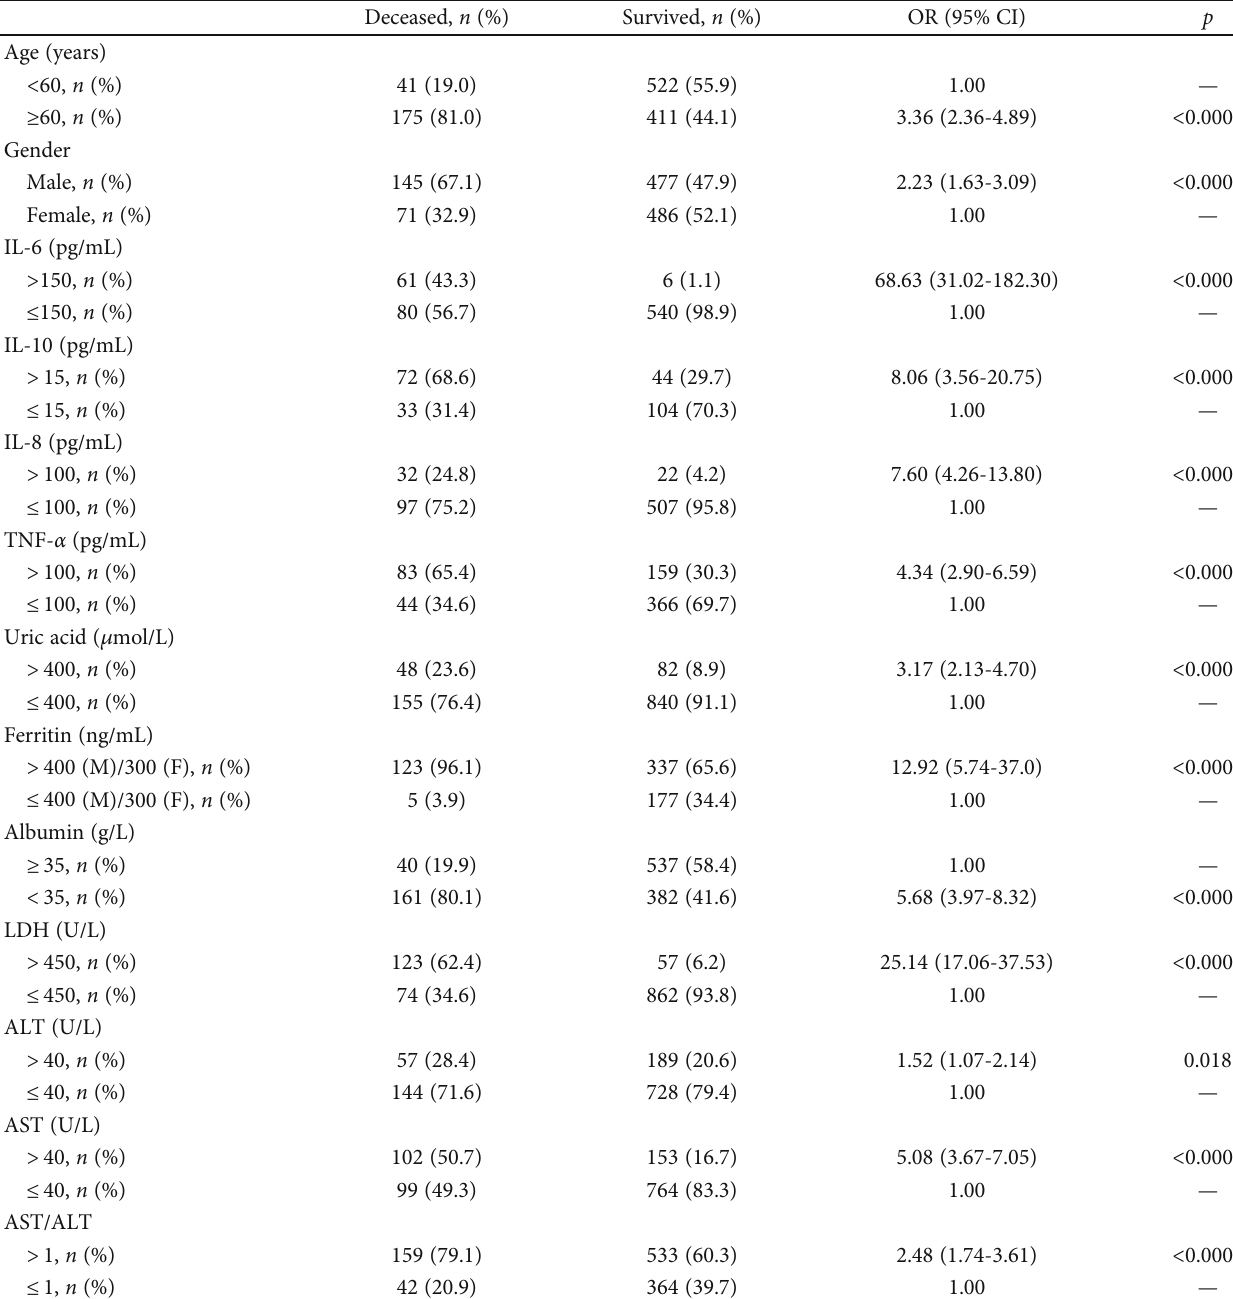
Table 1: Laboratory parameters in 1,149 COVID-19 patients hospitalized in Tongji hospital between 1/13/2020 and